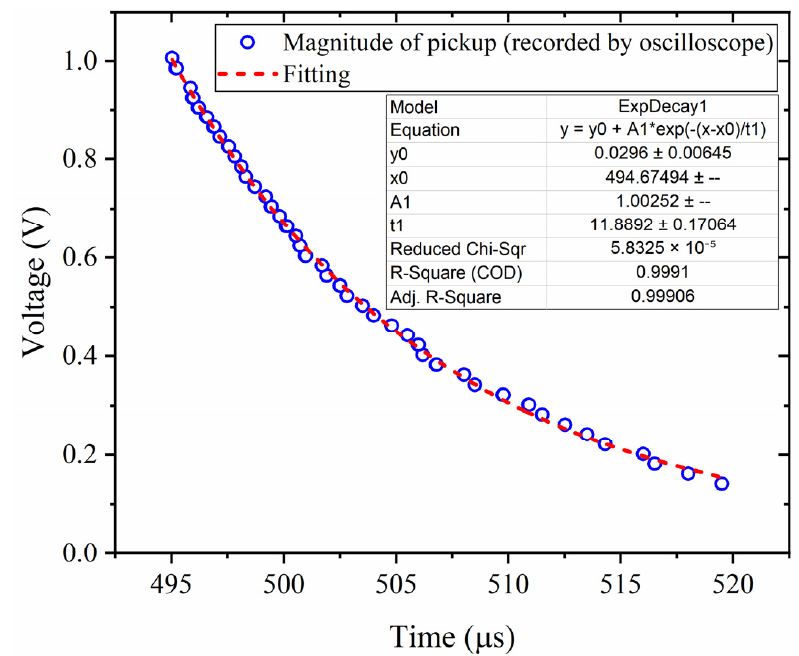
Figure 14. Exponential fitting of decay curve.